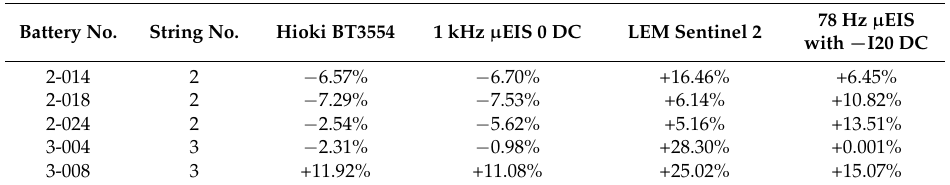
Table 4. Summary of relative change of the impedances registered by the different devices over 568 days in comparison for all investigated